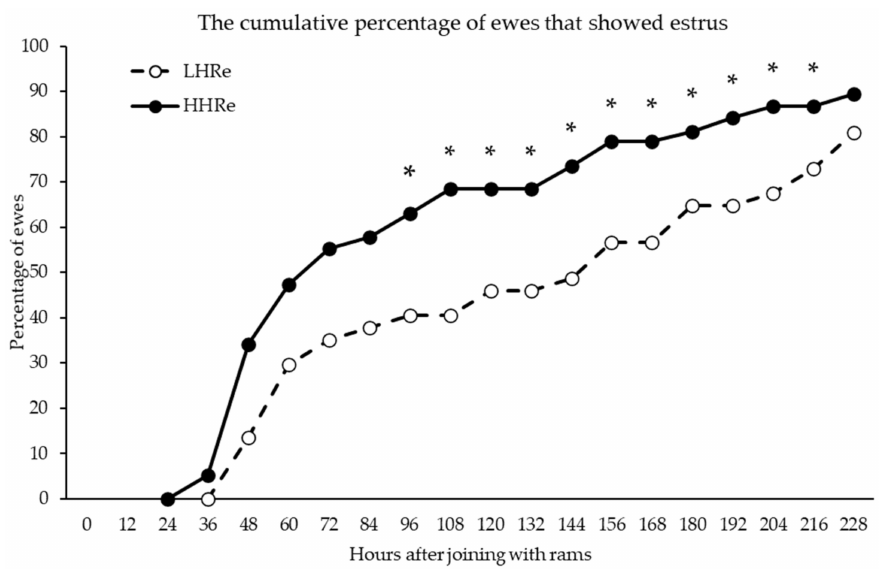
Figure 2. Cumulative percentage of ewes that showed estrus (%; n = 75) exposed to low ranked-rams (LHR) and high ranked-rams (HHR) under natural photoperiod. * Statistical differences between groups ( p <